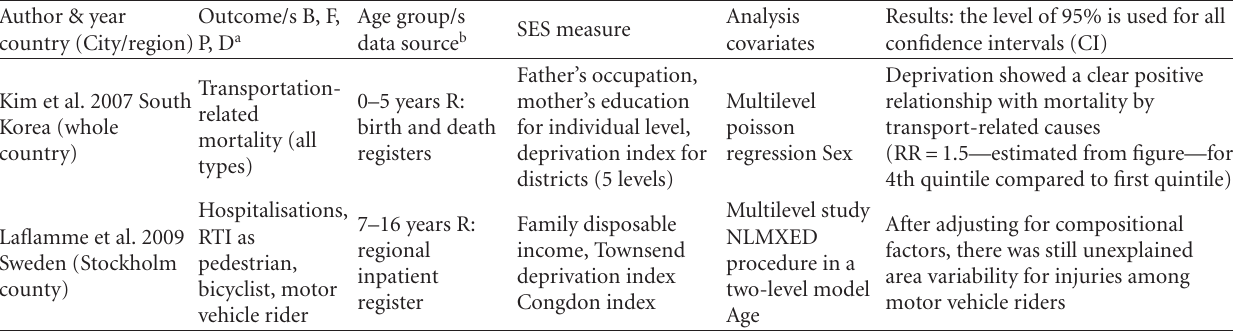
Table 4: Multilevel studies for childhood road tra ffi c injuries: summary of methodological features and results ( n = 2).